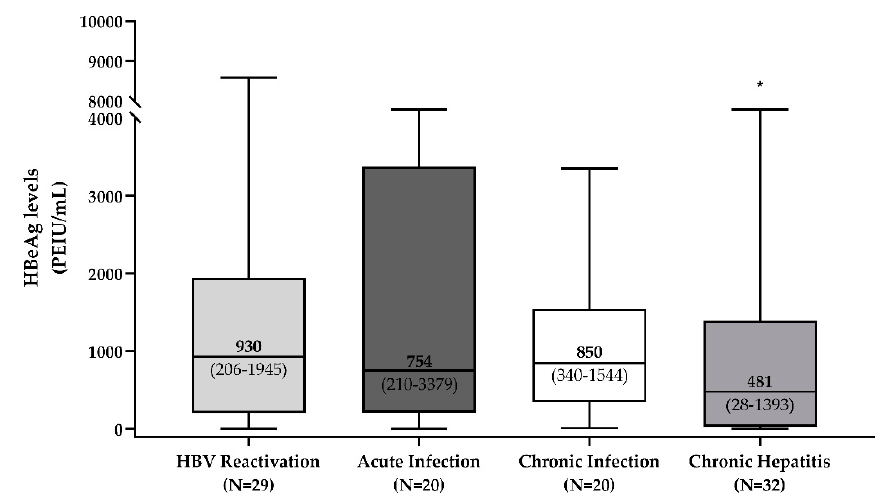
Figure 1. Distribution of HBeAg levels across different phases of HBV infection. The boxplot reports median, 25th and 75th percentile, min and max values of qHBeAg (expressed in PEIU/mL) in patients experiencing immunosuppression-driven HBV reactivation (N = 29), with acute infection (N = 20), with HBeAg-positive chronic infection (N = 20), with HBeAg-positive chronic hepatitis (N = 32). HBeAg was quantified by the CLIA Liaison HBeAg assay (DiaSorin). * Indicates the statistically significant difference ( p = 0.03) observed by comparing HBeAg levels in patients with HBeAg-positive chronic hepatitis versus those in the other three groups. Statistically significant difference was assessed by the Mann–Whitney test. Table 2. Correlation of HBeAg levels with virological and biochemicals markers. Correlation of HBeAg Levels